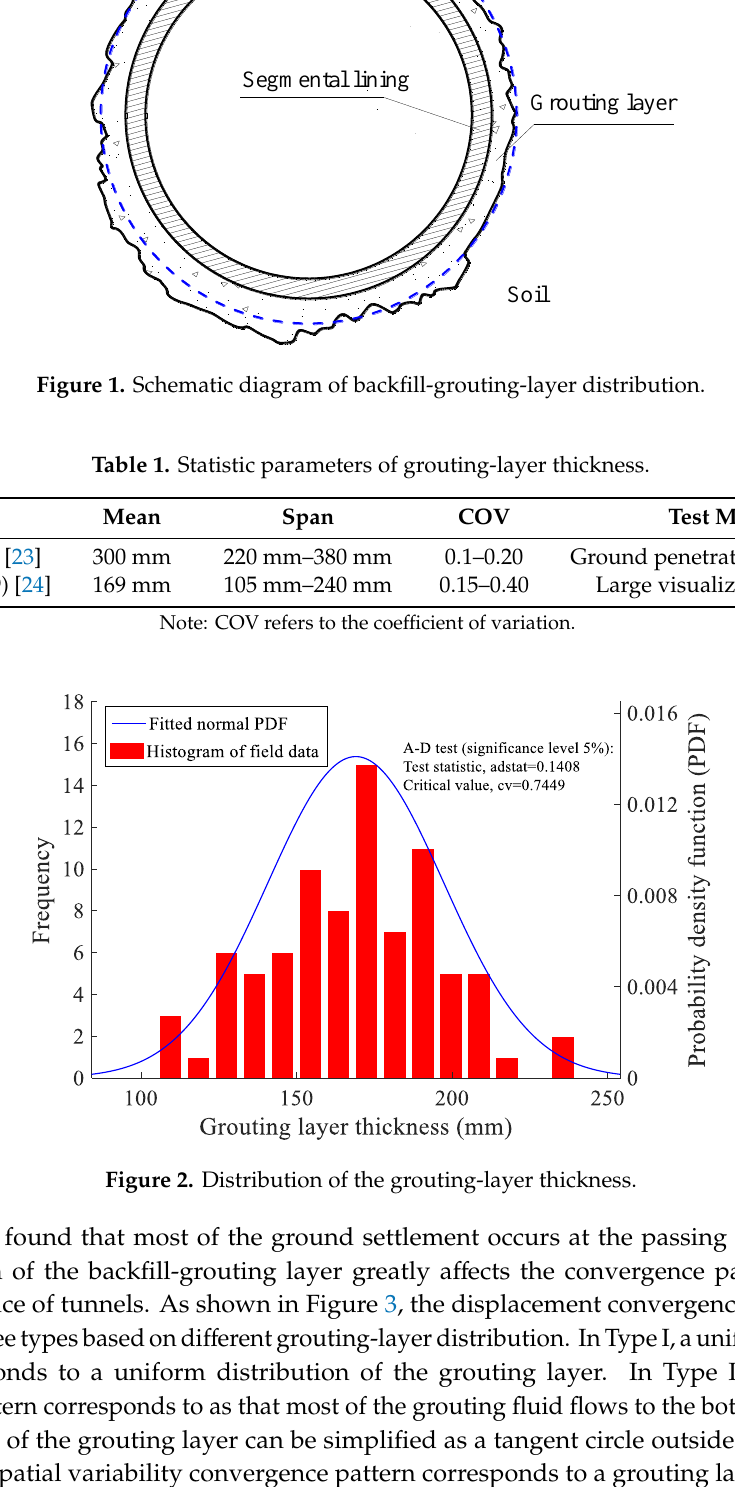
Figure 2. Distribution of the grouting-layer thickness.